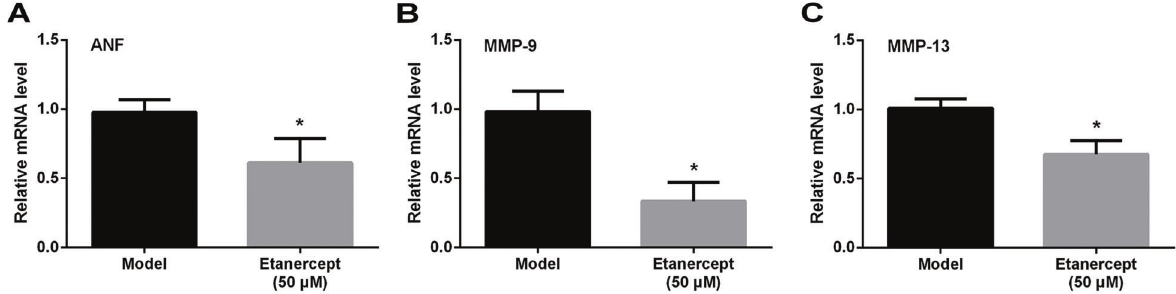
Figure 2. mRNA levels of atrial natriuretic factor (ANF, A ), matrix metalloproteinase (MMP)-9 ( B ) and MMP-13 ( C ) in cardiomyocytes with endothelin-induced hypertrophy treated with etanercept assessed by qRT-PCR. Data are reported as means ± SD. *P o 0.05 compared with model (ANOVA).